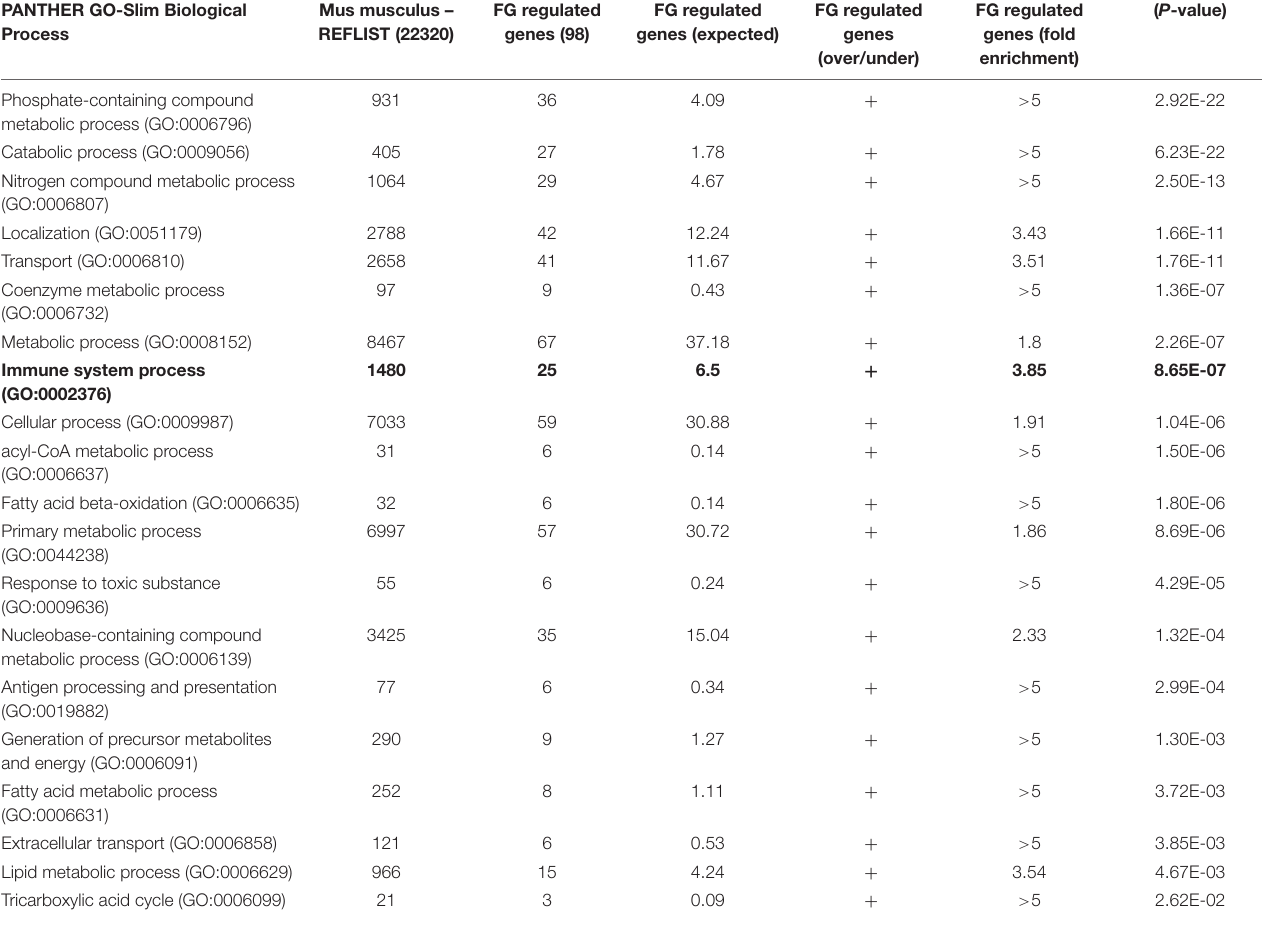
TABLE 1 | PANTHER over-representation analysis of fibrinogen regulated genes. PANTHER GO-Slim Biological